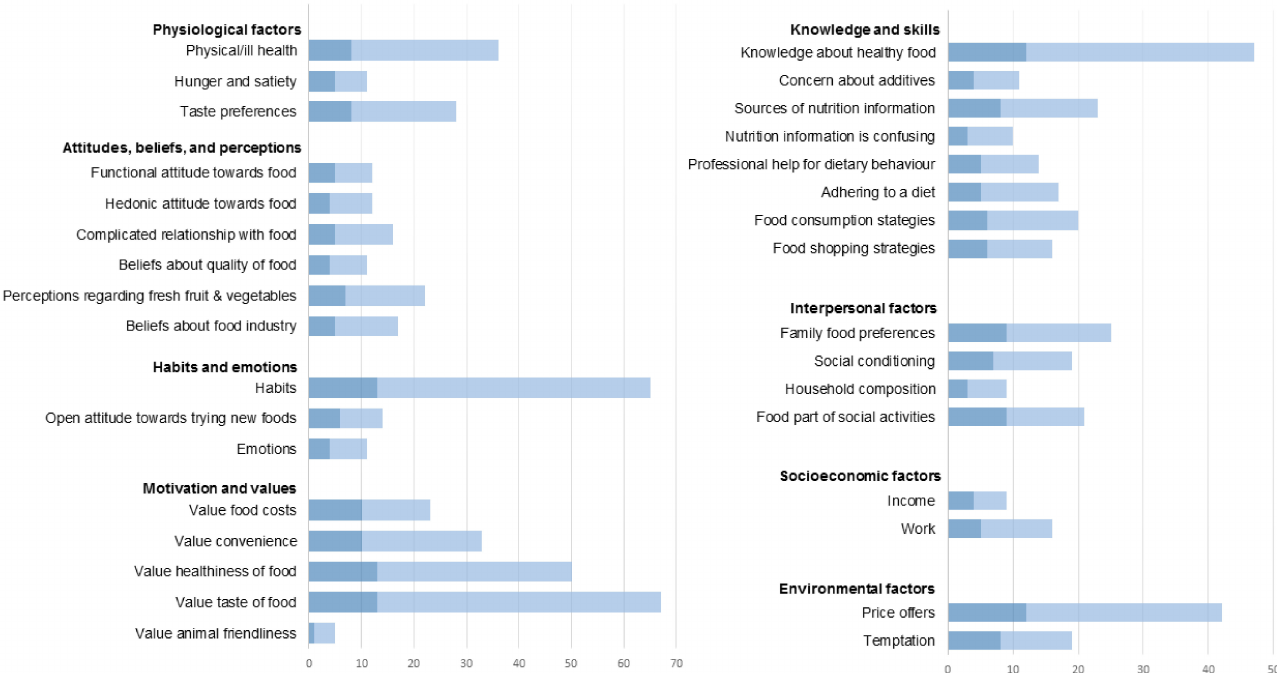
Figure 1. Interview and quotation frequency of perceived determinants of food